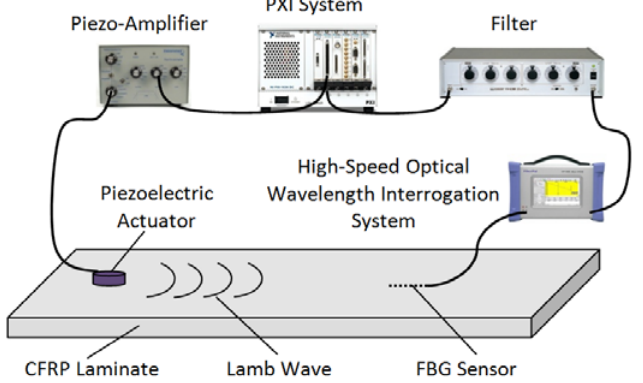
Figure 1. Guided wave and damage detection system using piezoelectric actuator and FBG.